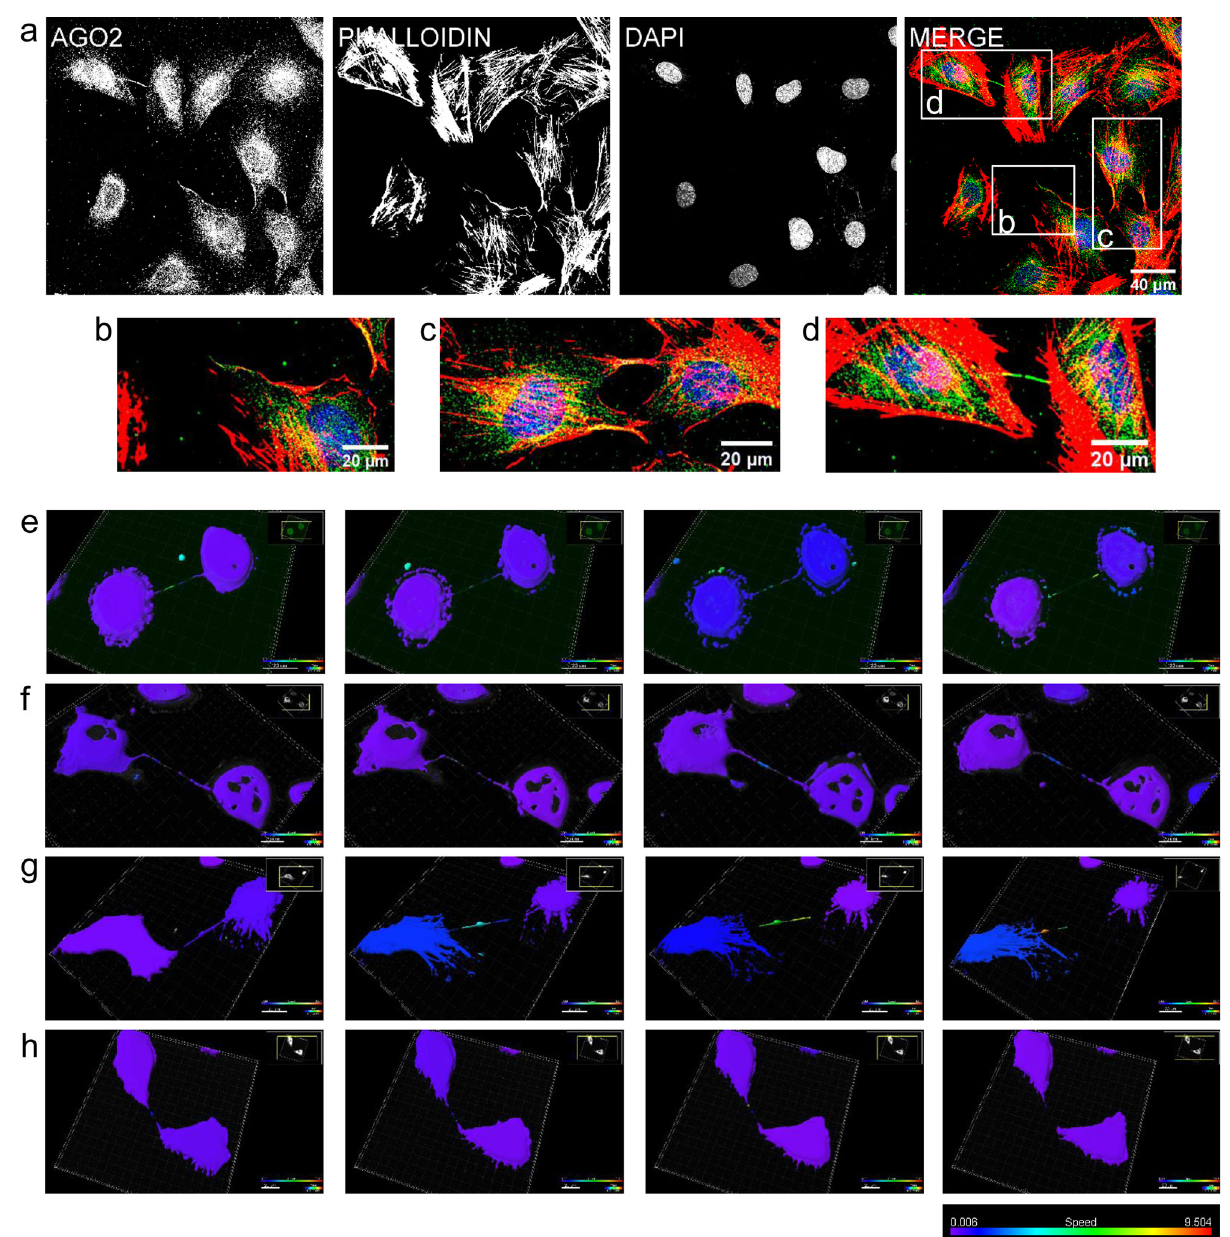
Fig. 1 Subcellular distribution of AGO2. a Representative immuno fl uorescence images of the NTHY ori 3-1 cells (scale bar: 40 μ m). Three types of AGO2 cellular protrusions are presented: b the typical Actin- fi lopodial structure (scale bar: 20 μ m), c the open-ended tunneling nanotube (scale bar: 20 μ m), and d the close-ended tubes (scale bar: 20 μ m). AGO2 was depicted in green, F-Actin in red (Texas red-phalloidin), and nuclei in blue (DAPI). 3D surface reconstruction of time points from time-lapse experiments of AGO2-GFP expressing cells; e , f open-ended tubes and g , h close-ended tubes, processed by Imaris software. Surfaces are color-coded (blue to red) according to speed (low to high), showcasing the motility of the respective objects. The scale bar is 20 μ